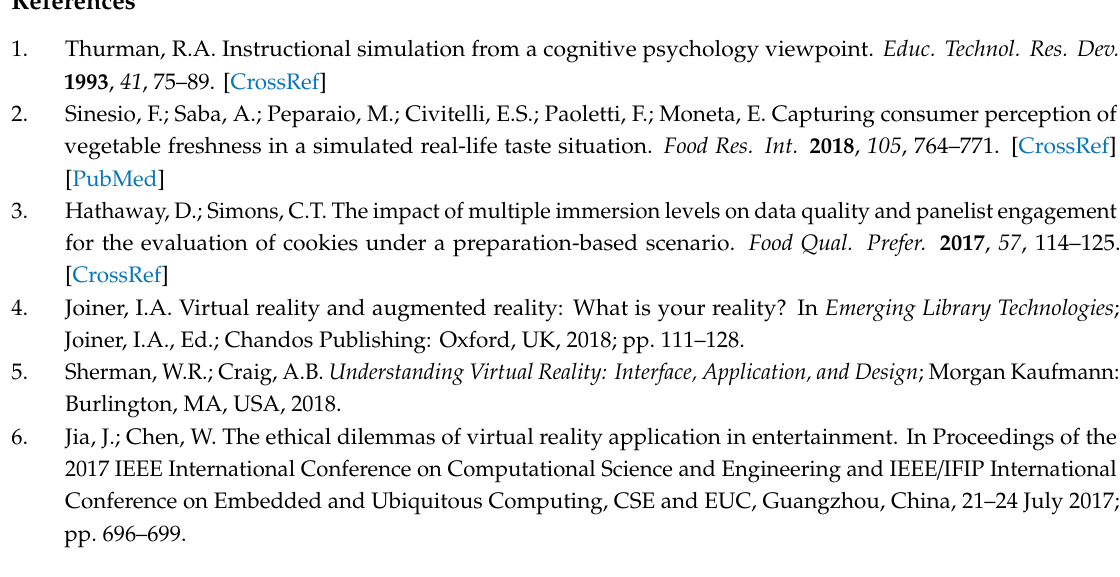
Table S1: Frequencies and significance of emotional terms based on Cochran’s Q